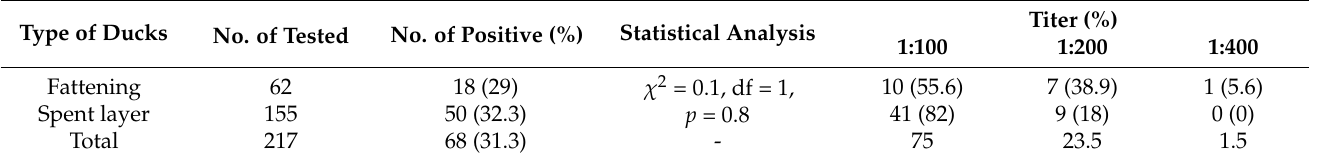
Table 1. T. gondii seropositive free-gazing ducks in this study.